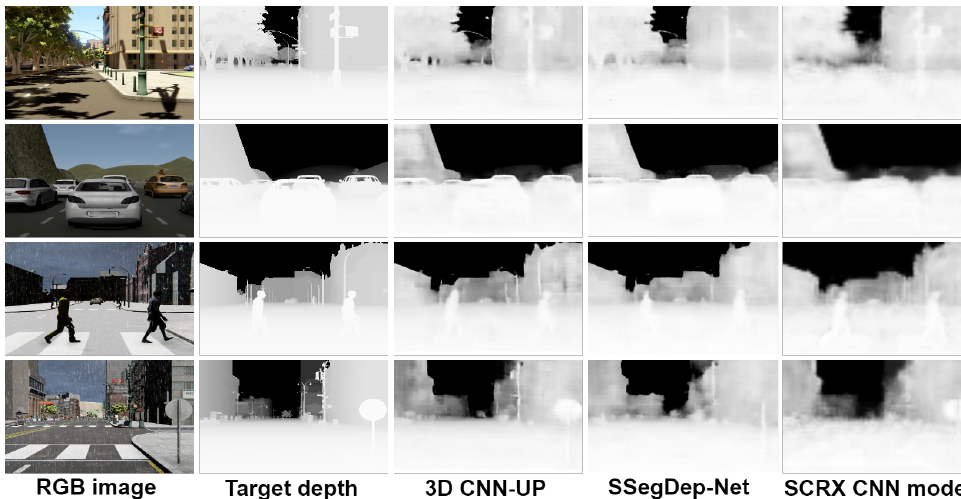
Figure 18. Comparison between the best results of all the CNN